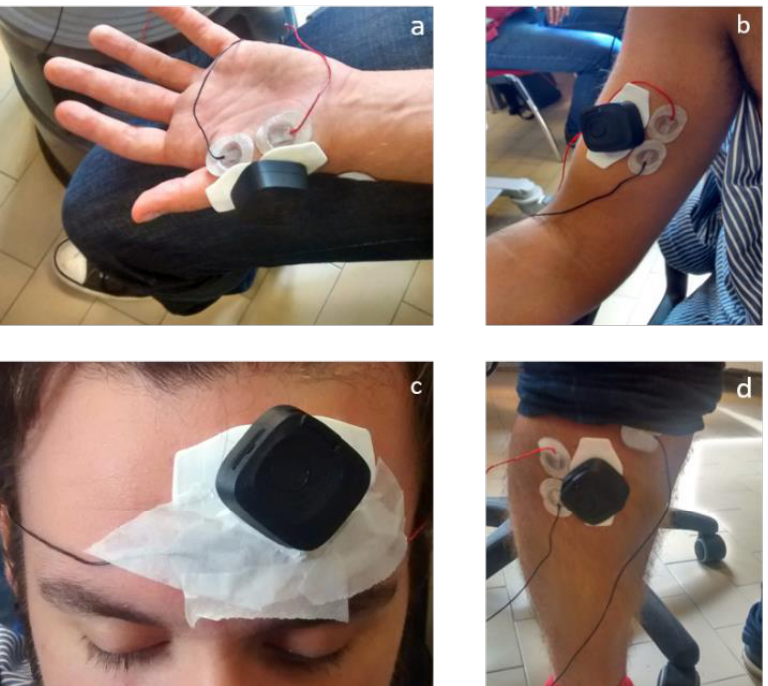
Figure 8. Placement of Digitimer D360 and Bio2Bit surface electrodes on the: ( a ) abductor pollicis brevis muscle; ( b ) biceps brachii muscle; ( c ) frontalis muscle; and ( d ) tibialis anterior.